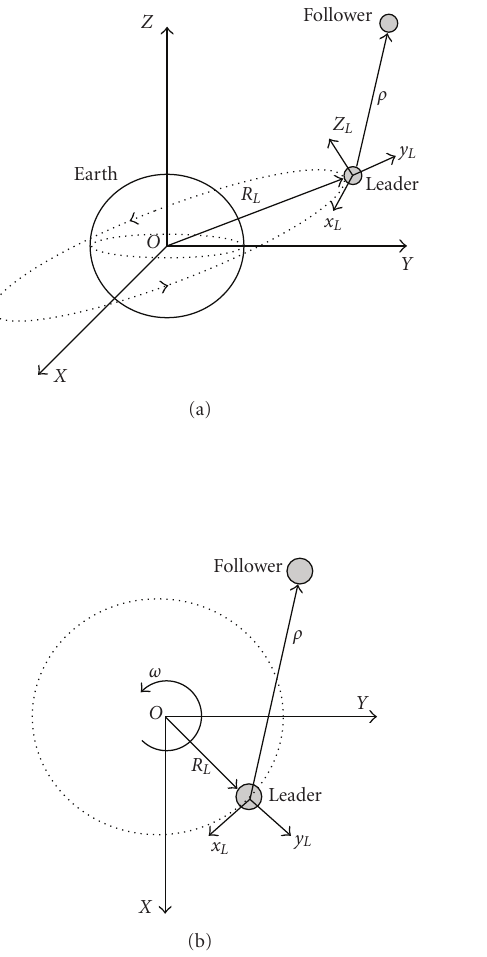
Figure 11: Schematic representations of the MSFF system.